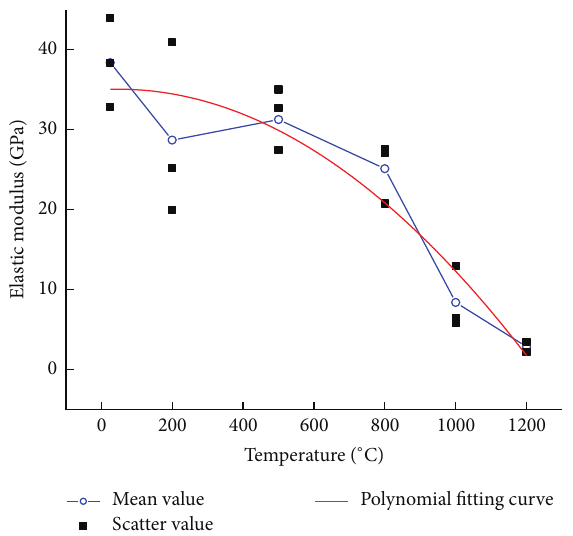
Figure 5: Variation of elastic modulus of rock samples with increasing